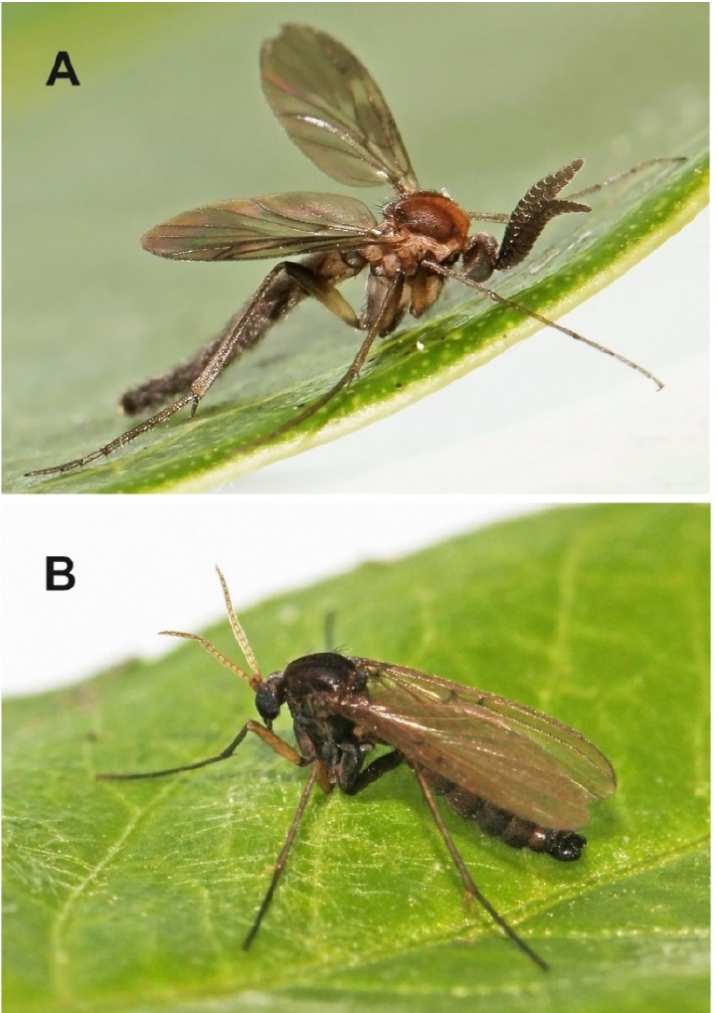
Figure 15. Photographs of living specimens. ( A ) Setostylus fangshuoi sp. nov. (holotype, male); ( B ) Hadroneura martini sp. nov. (holotype, male). Photo by J. Šev č ík. Scale bar: 1 mm.